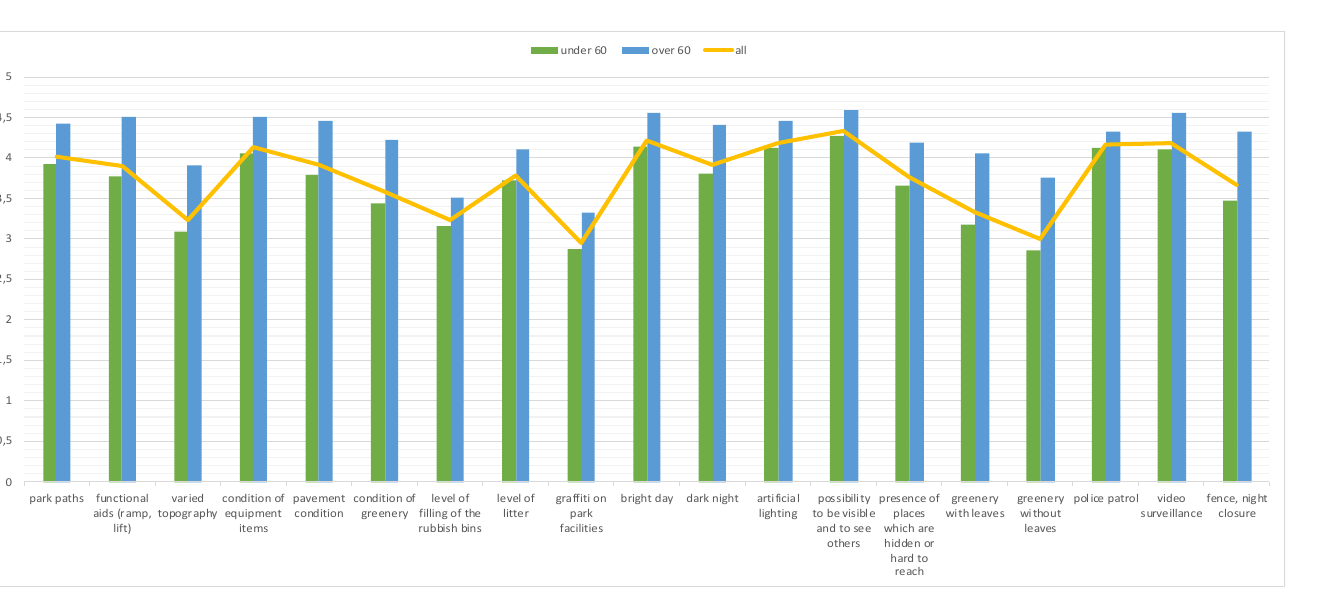
Figure 2. Summary of indications of the significance of factors influencing the perceived security of respondents by age (elaborated by authors).